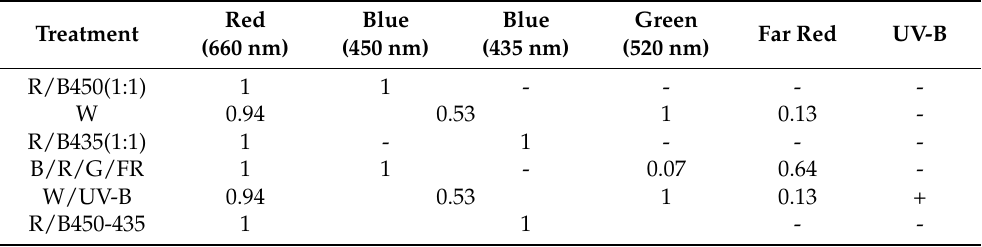
Figure 1. Spectra of the lighting treatments used, as measured by a UPRtek spectrophotometer (Zhunan Township, Miaoli County 35059, Taiwan). Table 1. The relative ratio of light spectrum in the applied treatments (R refers to red, B refers to blue, W refers to white, G refers to green, FR refers to far-red and UV to